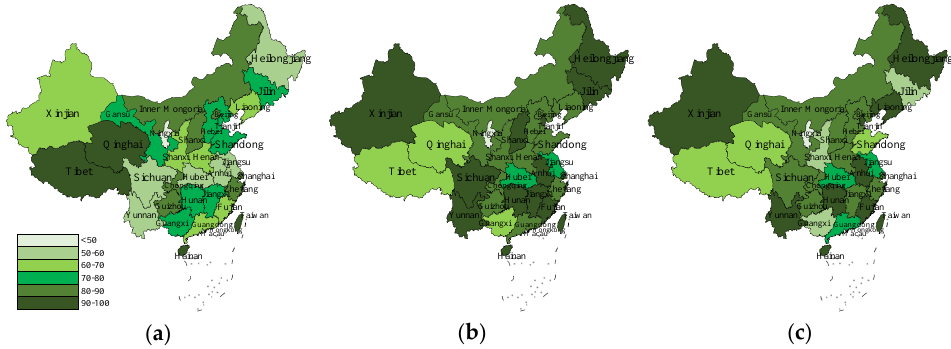
Figure 4. Distribution of travel and willingness to participate in rural tourism. Note 1. ( a ) The percentage distribution of people who chose “YES” to question BEH, “Go out to rural tourism to relax in the last month”. ( b ) The percentage distribution of people whose average travel intention was greater than 3. The average was calculated from the terms TI1-TI3. ( c ) The percentage distribution of people whose average travel intention was greater than 3. The average was calculated from the terms RI1-RI3. Note 2. Measures for all items were assessed with a five-point Likert scale from “Extremely unlikely / disagree / little / unacceptable “(1) to “Extremely likely / agree / well / acceptable” (5). Note 3. The unit of data in the figure was “%”.